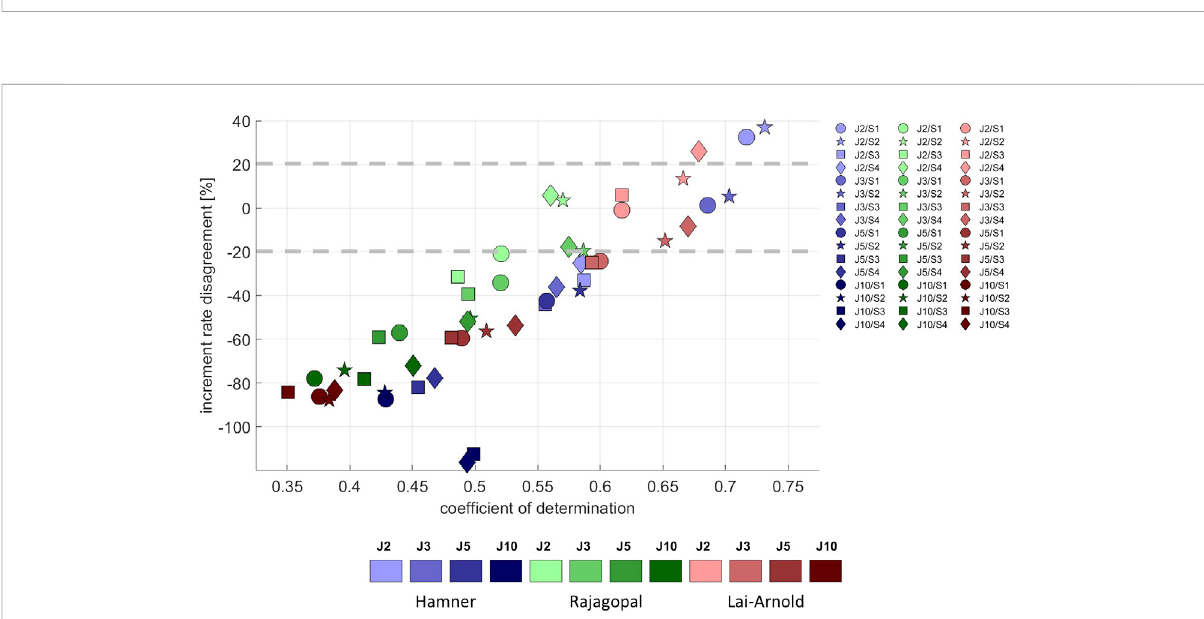
FIGURE 4 RMSE versus correlation coef fi cient (r) between normalized EMGs and estimated muscle excitations in 8 muscles, averaged values among all subjects and speeds, with performance criteria based on minimization of muscle effort to the power of 2 (J2), 3 (J3), 5 (J5), and 10 (J10), illustrated with darkening colors, and scaling variants of linear scaling of OFL and TSL and generic MIF (S1), non-linear scaling of OFL and TSL and generic MIF (S2), linear scaling of OFL and TSL and scaled MIF (S3), and non-linear scaling of OFL and TSL and scaled MIF (S4).